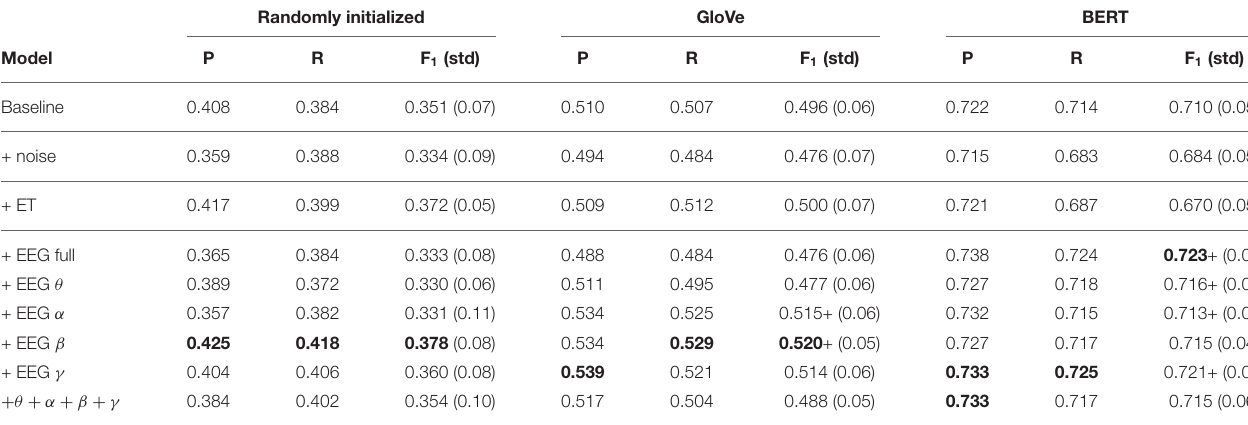
TABLE 8 | Ternary sentiment analysis results of the multi-modal model using the convolutional EEG decoding component . Randomly initialized GloVe BERT